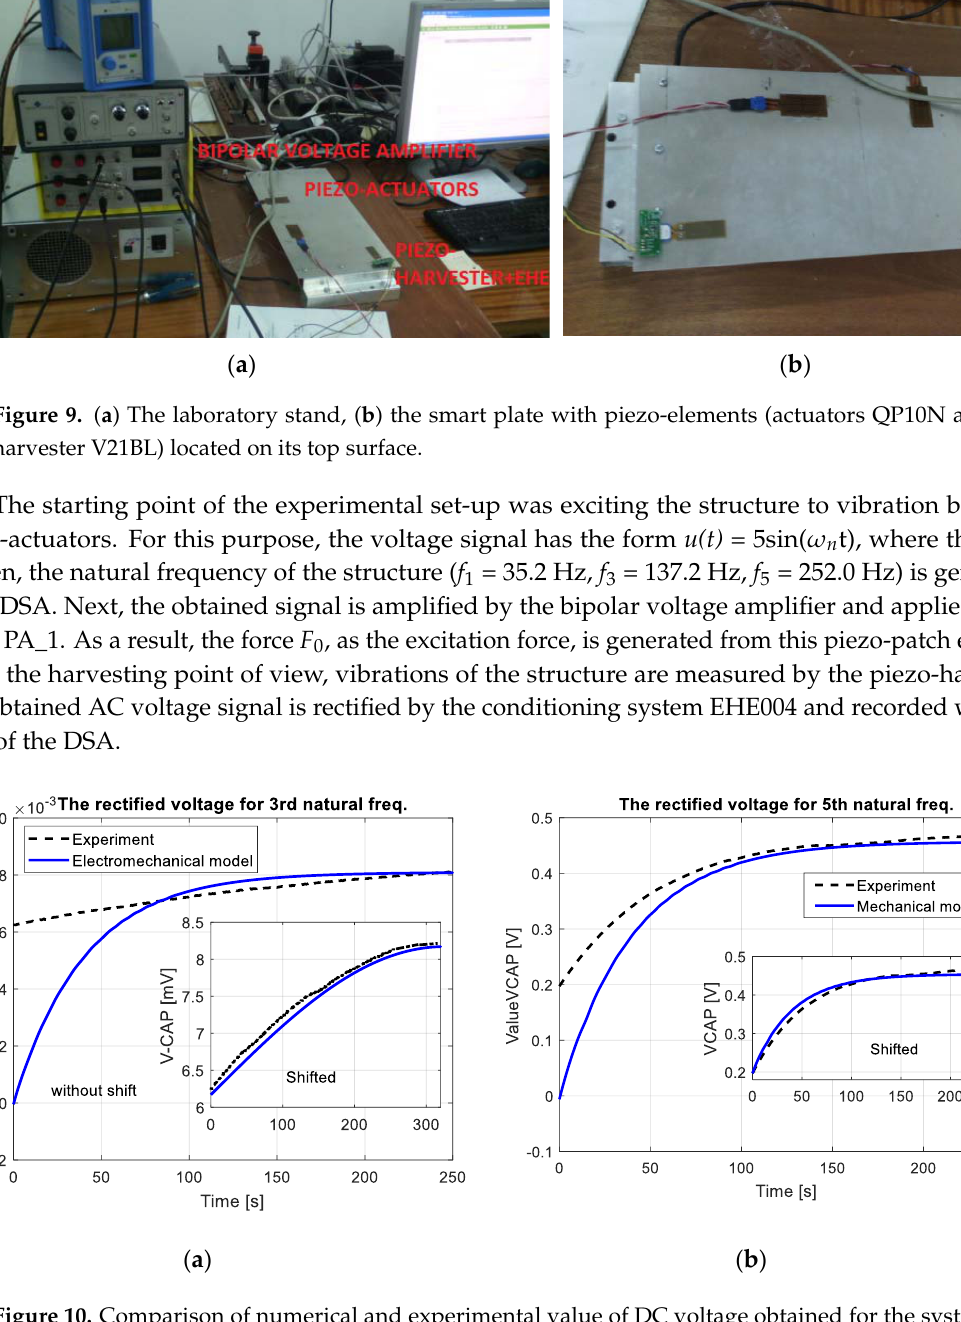
Figure 10. Comparison of numerical and experimental value of DC voltage obtained for the system excited to vibration with ( a ) 3rd natural frequency, ( b ) 5th natural frequency. .